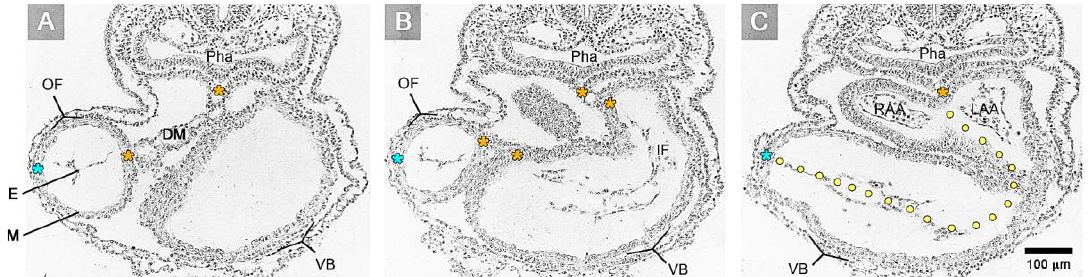
Figure 1. These transverse histological sections of a human embryo with 10 pairs of somites (Carnegie stage 10) show the inner architecture of an S-shaped heart tube as seen in routine histological preparations. The heart was fixed in a systolic state so that its lumen is partially obliterated. ( A ) Section at the level of the proximal outflow (= OF) of the ventricular tube. ( B ) Section of at the level of the inflow (= IF) of the ventricular tube. ( C ) Section at the level of the developing – right and left atrial appendages (= RAA, LAA). Note that the myocardium (= M) and endocardium (= E) are separated by an “empty” space, called the myoendocardial space. Note also: (1) The difference in the thickness of the myoendocardial space between the developing atria and ventricles; and (2) the paired character of the myoendocardial space, which reflects the origin of the heart from bilaterally paired heart fields. The dorsal mesocardium (= DM, and indicated by orange asterisks) and the obliterated endocardial tube can be used as anatomical landmarks for the original midsagittal fusion plane of the left- and right-sided heart fields (marked by the dotted line in section C). Light blue asterisks mark the original ventral midline of the heart tube. Further abbreviations: VB = ventricular bend; Pha = pharynx/foregut.